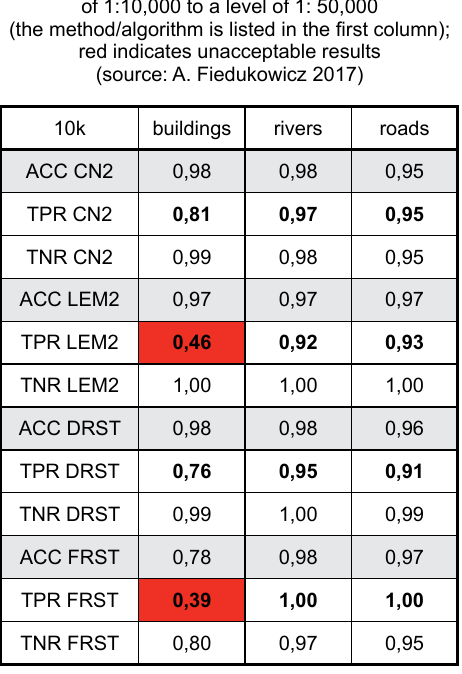
Table 3. Averaged results (using a cross-validation) for selecting model